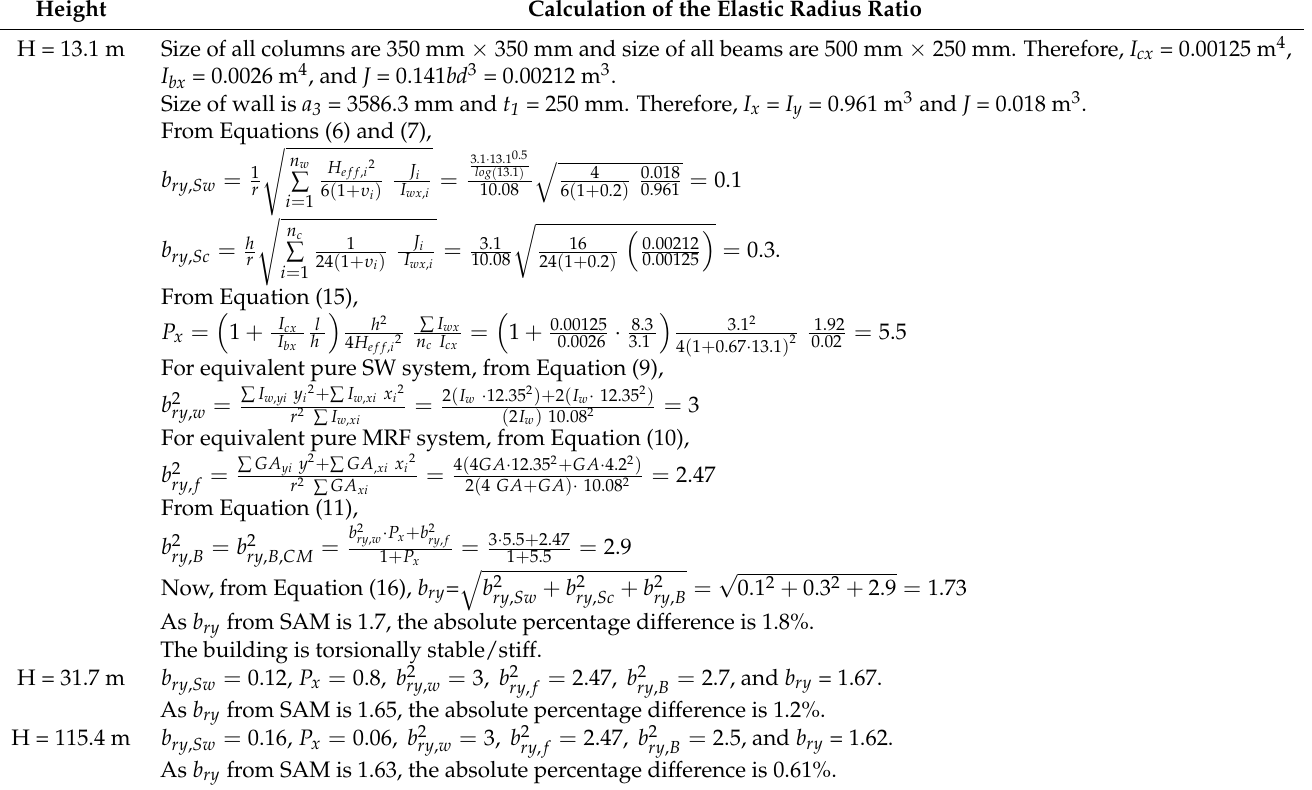
Table A1. Calculation of the Elastic Radius Ratio for Building Model